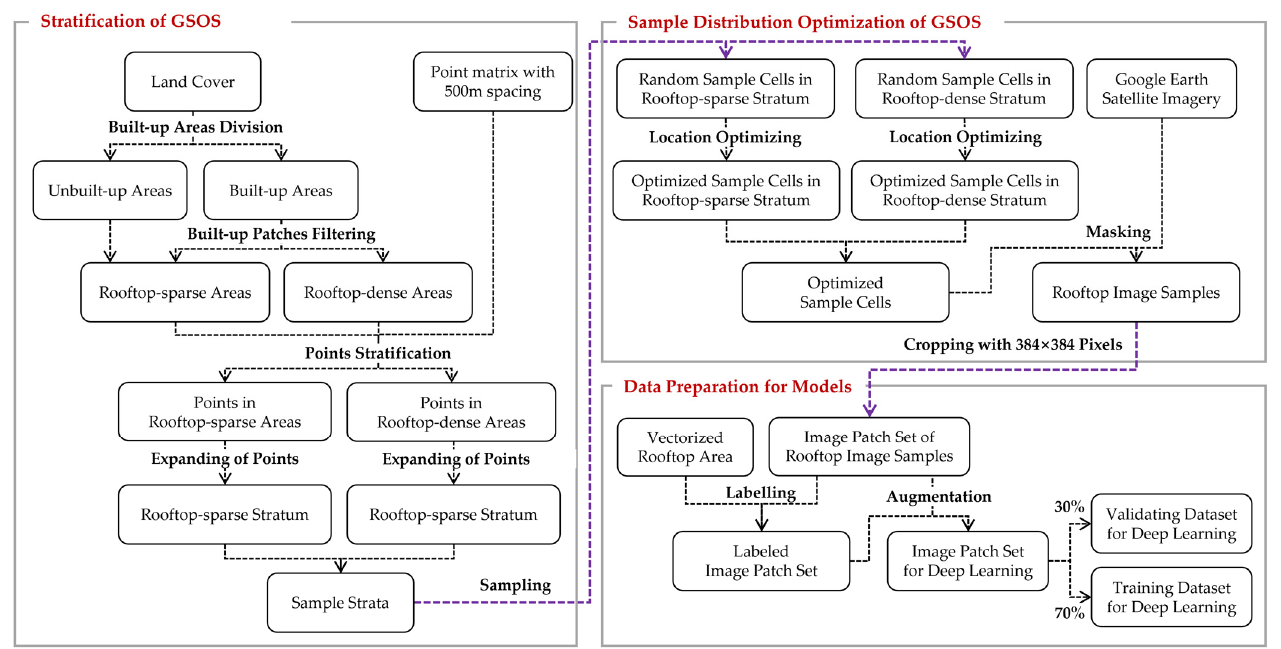
Figure 6. The working framework for training dataset collection based on GSOS.